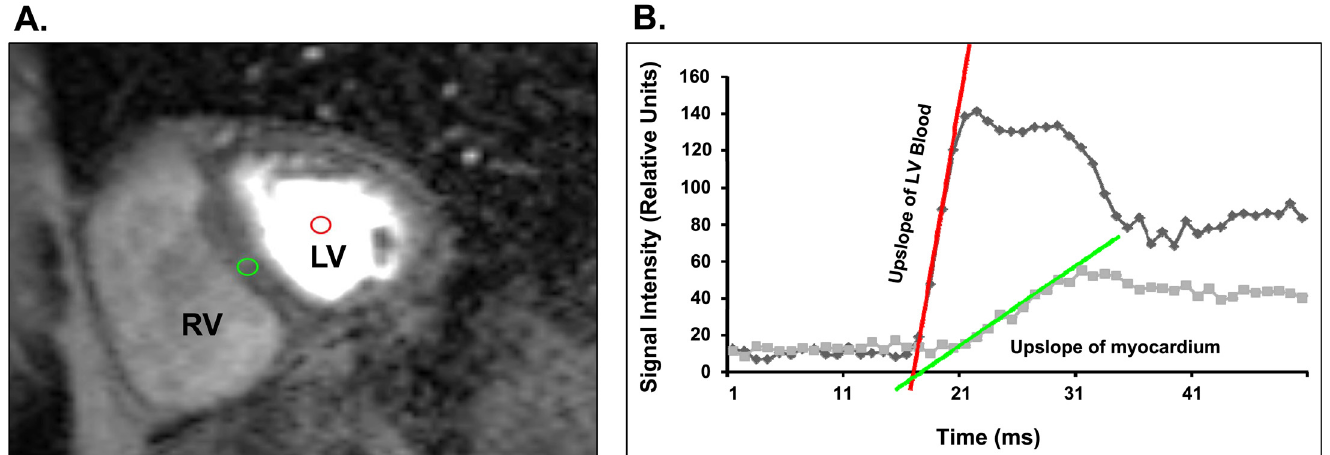
Fig 1. Measurement of myocardial perfusion index. (A) Segment from representative mid-ventricular slice during first-pass perfusion imaging during peak dose dobutamine stress. Red region of interest defines the middle of the left ventricle (LV) for measuring the slope of blood, and the green circle defines the middle interventricular septal myocardium which was used to measure the slope of myocardial perfusion. (B) The signal intensities (Y-axis) over time (X-axis) were plotted for blood (red) and LV myocardium (green). The upslope of LV blood and upslope of LV myocardium were plotted and used for determination of myocardial perfusion index (MPI).